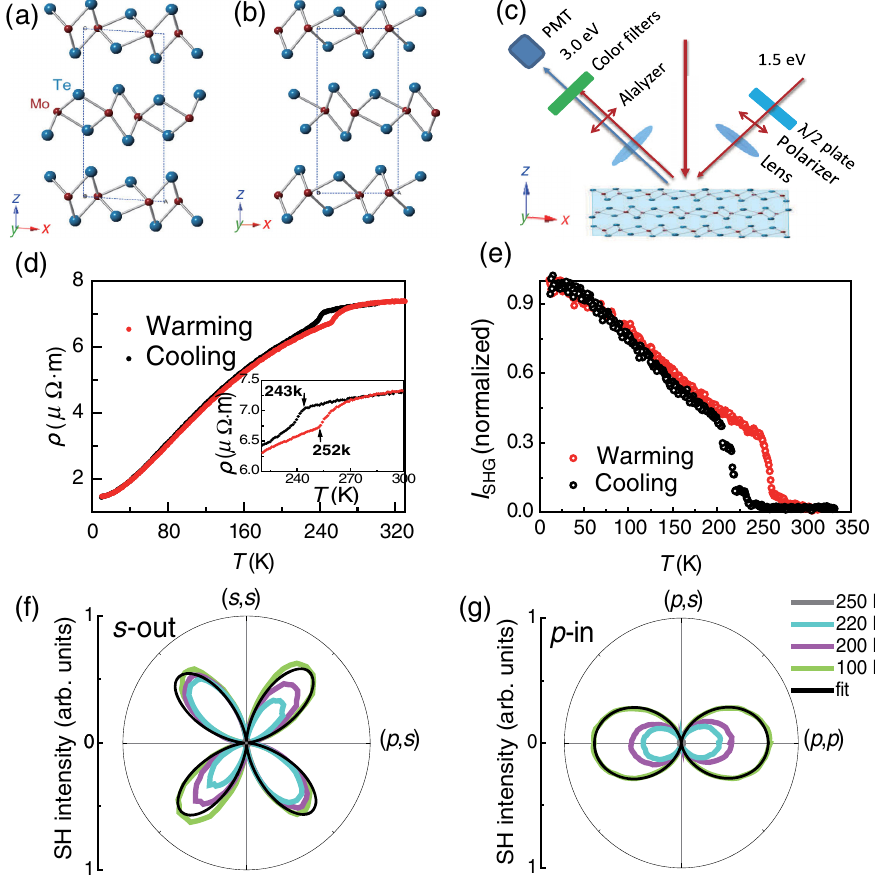
FIG. 1. Sample structure and characterization. Crystal structures of MoTe 2 in the (a) 1 T 0 and (b) T d phases. Beam path in the SHG experiment is shown in (c). (d) T -dependent resistivity. (e) Optical SHG intensity measured with an incident photon energy of 800 nm. Both ρ ð T Þ and the SHG measurement show a temperature-induced first-order phase transition. SHG characteristics (f) for the s -polarized SH photons while the incidence polarizer is rotated and (g) for the incidence p polarized while the SH analyzer is